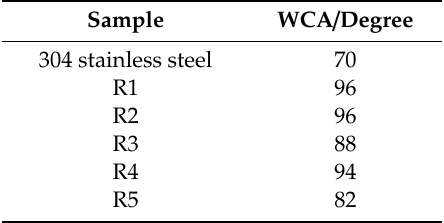
Table 3. Water contact angle (WCA) values of bare 304 stainless steel and samples